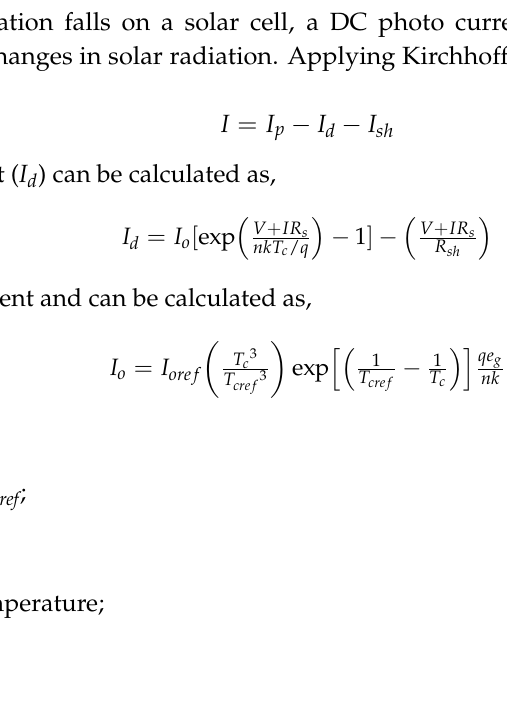
Figure 2. Equivalent circuit of single diode solar cell.